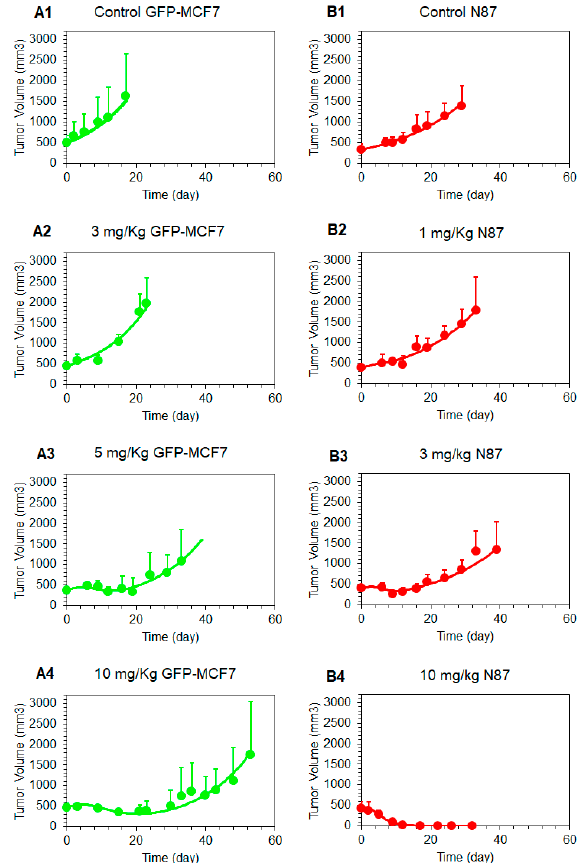
Figure 6. Observed and model predicted tumor growth profiles in GFP-MCF7 (green) and N87 (red) tumor bearing mice in either control group ( A1 , B1 ) or after 1 mg/kg ( B2 ), 3 mg/kg ( A2 , B3 ), 5 mg/kg ( A3 ), and 10 mg/kg ( A4 , B4 ) T-vc-MMAE.